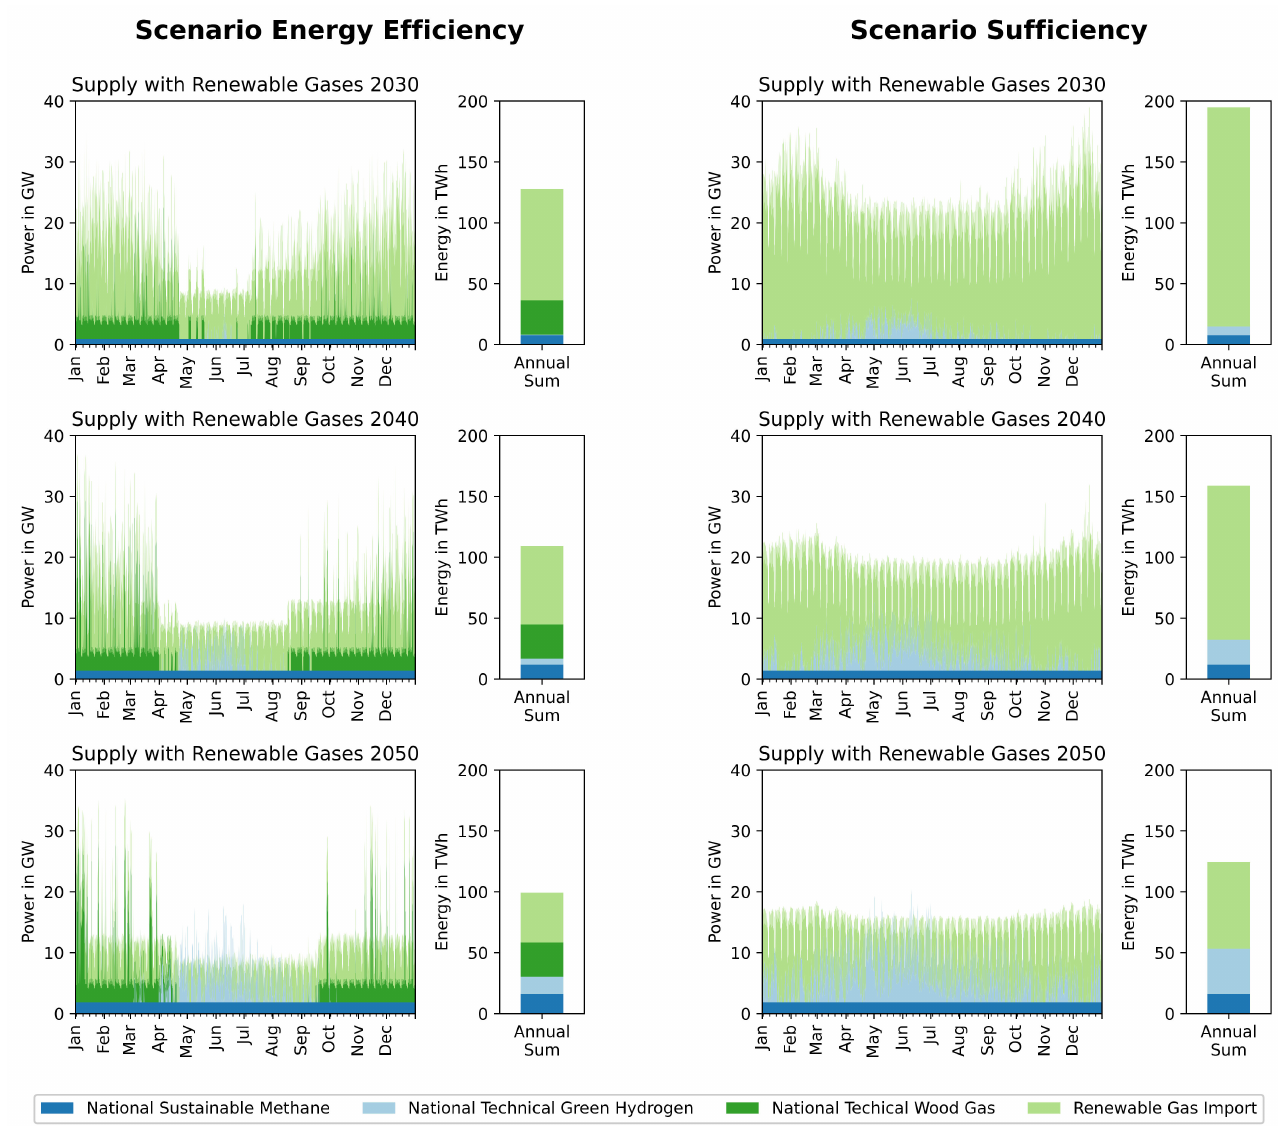
Figure 9. Sources of the required renewable gases. For each scenario and each considered year, the temporally resolved diagram and the annual sum of the technical potentials and import demand are